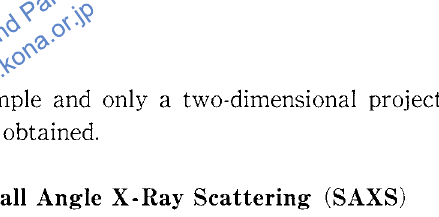
1 q"' 1/r log scattering vector Fig. 4 Typical small angle scattering intensity for a particle network such as aerogel. explained by a fractal network. The intensity drops as Icx:q- 0 , where the exponent Dis called the